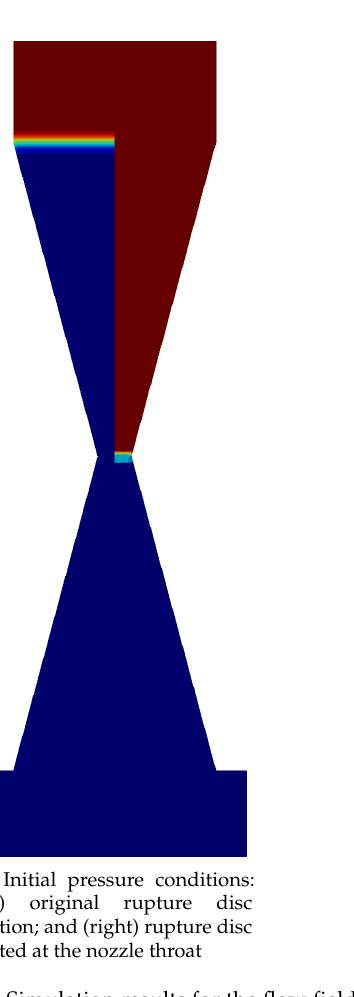
Figure 13. Simulation results for the flow field for two different rupture disc locations.